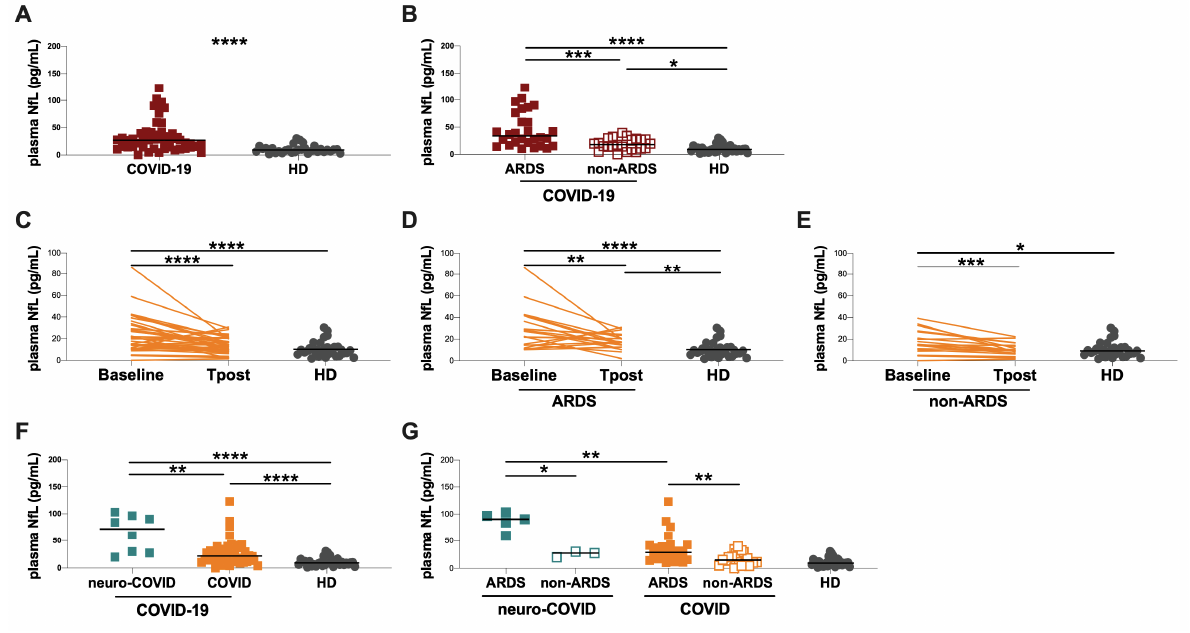
Figure 2. Evaluation of plasma NfL levels in COVID-19 patients and healthy donors. ( A ) Evaluation of plasma NfL levels in COVID-19 patients and HD. ( B ) Evaluation of plasma NfL levels in patients with ARDS (ARDS group), patients without ARDS (non-ARDS group) and HD. ( C ) Longitudinal evaluation of plasma NfL levels in COVID-19 patients. ( D ) Longitudinal evaluation of plasma NfL levels in COVID-19 patients who developed ARDS during hospitalization. ( E ) Longitudinal evalua- tion of plasma NfL levels in COVID-19 patients who did not developed ARDS during hospitalization. ( F ) Evaluation of plasma NfL levels in COVID-19 patients with severe neurological symptoms (neuro- COVID group), COVID-19 patients without severe neurological symptoms (COVID group) and HD. ( G ) Evaluation of plasma NfL levels in neuro-COVID and COVID groups stratified according to ARDS. Horizontal lines represent medians. COVID-19: coronavirus disease 2019; neuro-COVID group: COVID-19 patients with severe neurological symptoms; COVID group: COVID-19 patients without severe neurological symptoms; NfL: neurofilament light chain; HD: healthy donors; ARDS: acute respiratory distress syndrome; CSF: cerebrospinal fluid. ****: p < 0.0001; ***: 0.0001 < p < 0.001; **: 0.001 < p < 0.01; *: 0.01 < p <